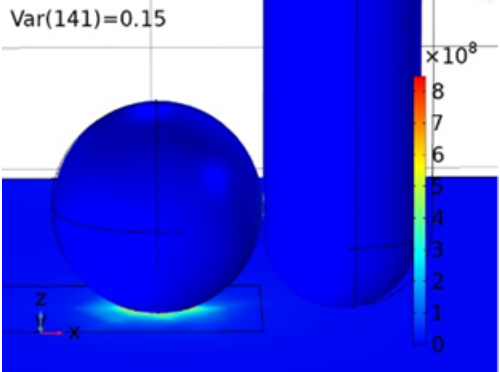
Figure 2. The simulation of the probe driving the nanoparticle.